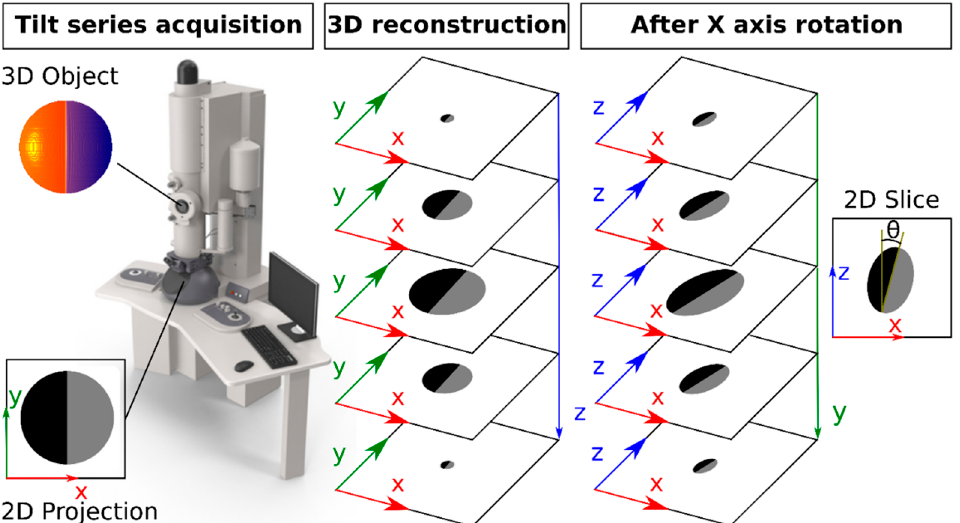
Figure A4. Clarification of how φ and θ , the angles of rotation around the X and Y axis, were retrieved. Left: a 3D object is projected in 2D (XY plane) but recorded at many different tilt angles (= a tilt series). Middle: Based on a series of 2D projections in the XY plane at different angles, tomographic algorithms can reconstruct the Z-dimension. Right: 90° rotation around the X axis ( φ = 90°) yields a side view of the particle. It is in this XZ plane that θ can be observed and measured.